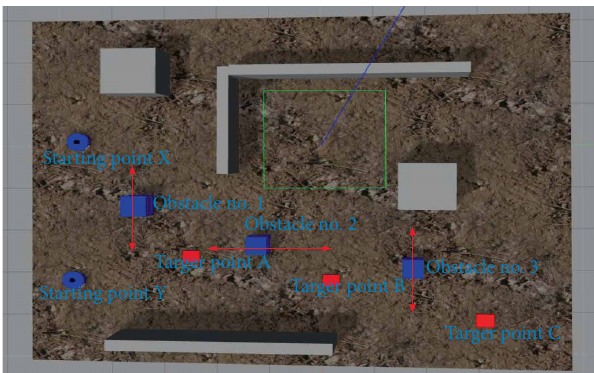
Figure 15: Dynamic scene test diagram of TDDQN and D